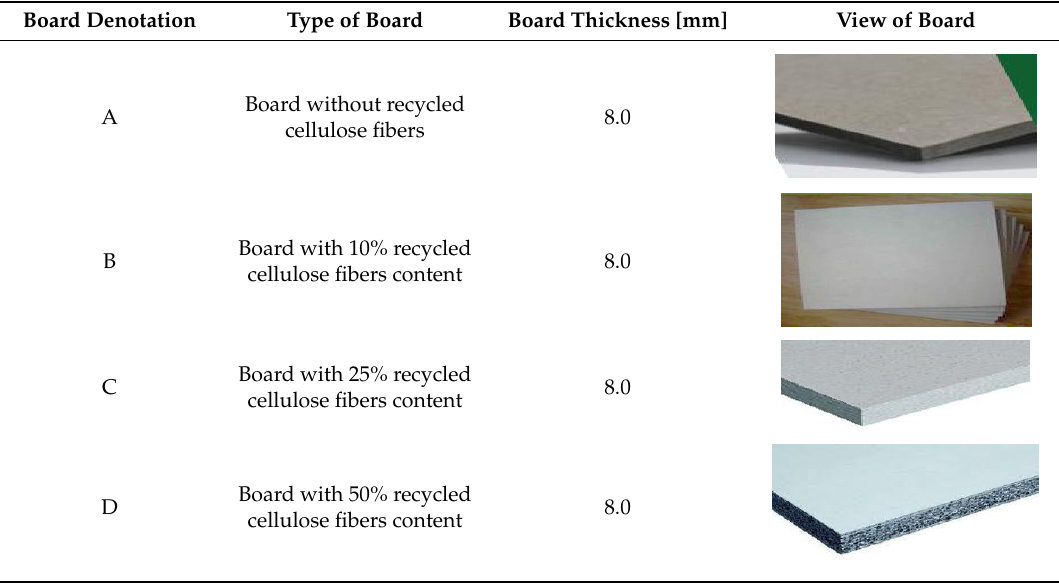
Table 3. Specification of tested fiber cement boards.